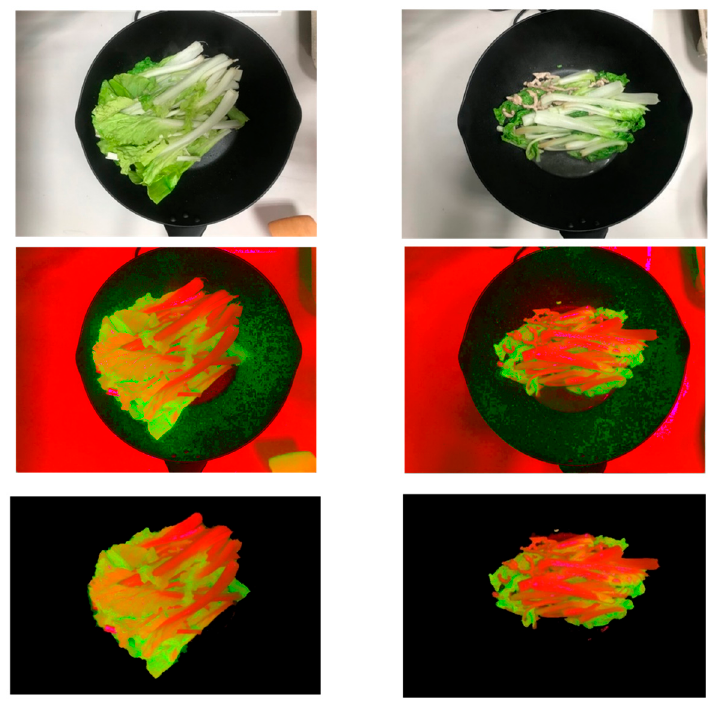
Figure 6. The cooking of the Chinese cabbage. Upper: Lettuce original image, Middle: HSV false color operation image, Bottom: target extraction. Left: Beginning. Right: Finish.